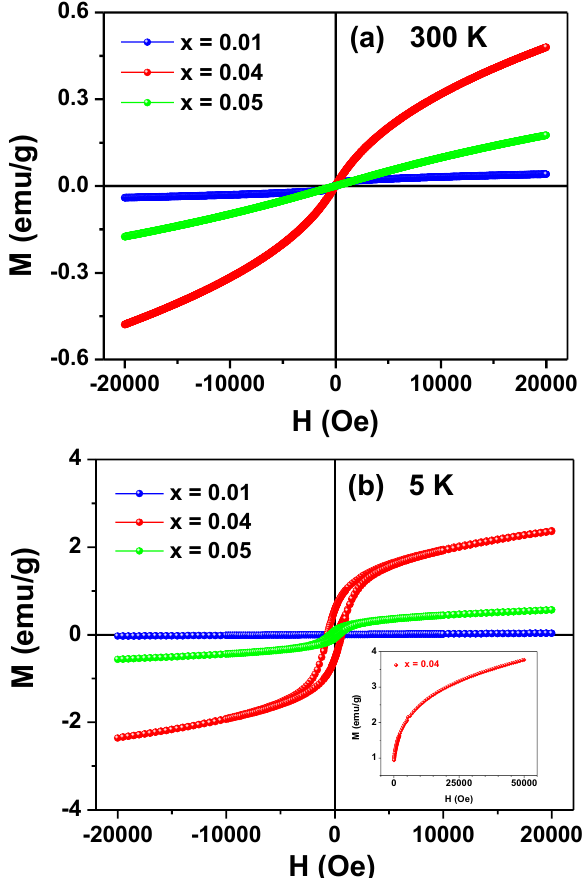
Figure 6. M (H) curves taken at 300 K ( a ) and 5 K ( b ) for the Zn 1-x Fe x O samples. The insert in ( b ) shows the initial magnetization curve for the x = 0.04 sample up to the limit field of 50 kOe ( µ o H = 5 T). None of the M (H) curves reached saturation under applied fields of up to 20 kOe. In fact, the sample x = 0.04 did not reach saturation even for H = 60 kOe at 5 K (see insert in Figure 6b), exposing another evidence of the SG state of the